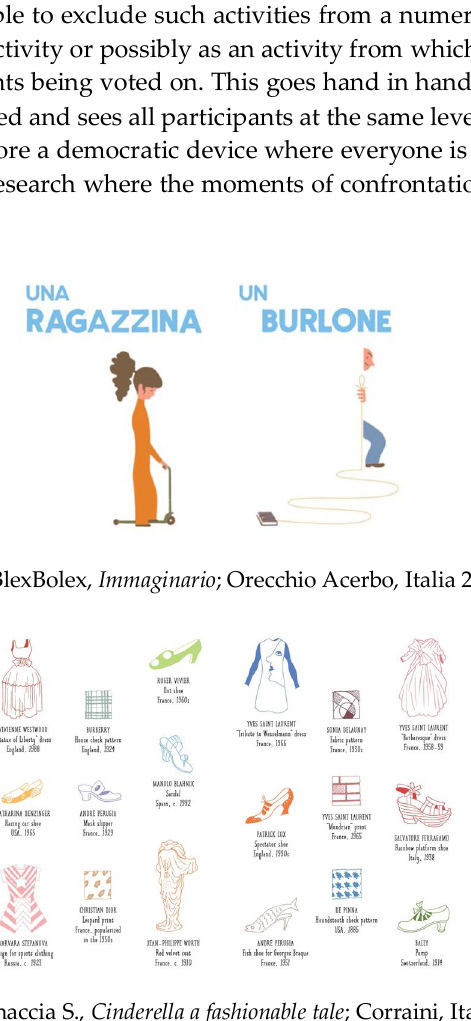
Figure 14. Guernaccia S., Cinderella a fashionable tale ; Corraini, Italia 2013,